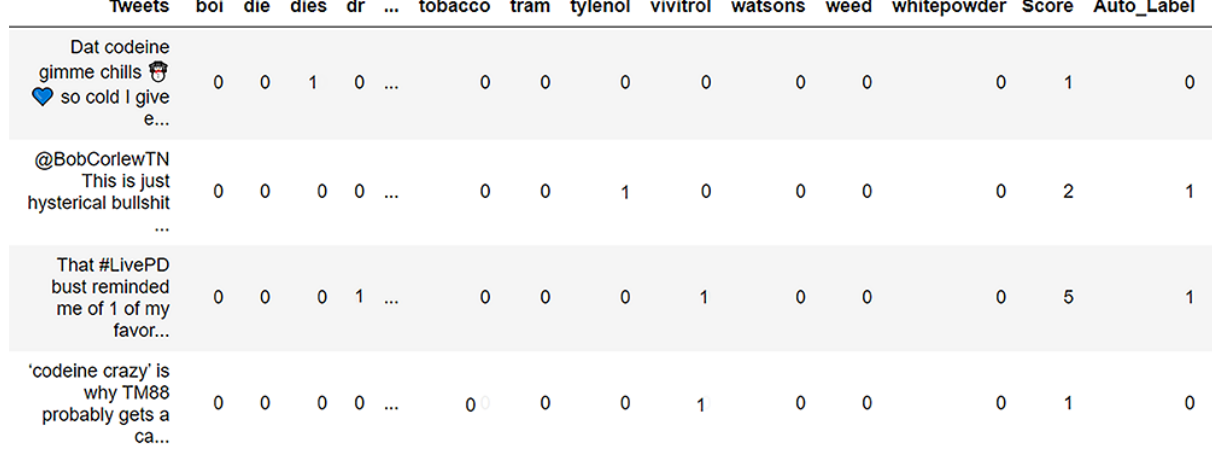
Figure 8. Sample outcomes from the evaluation matrix, where tweets autolabeled 0 are irrelevant and tweets autolabeled 1 are relevant.